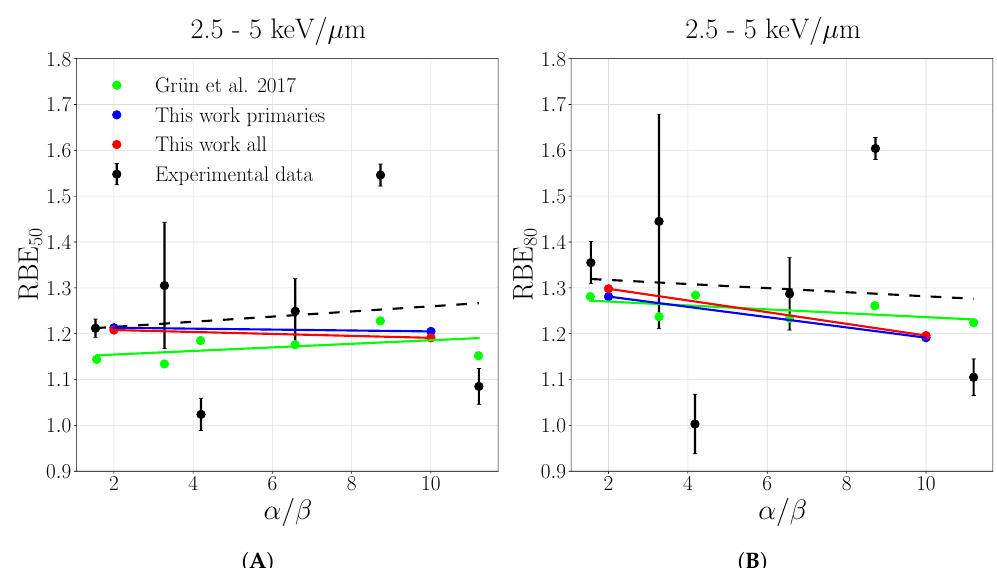
Figure 11. RBE 50 ( A ) and RBE 80 ( B ) as a function of α / β ratio evaluated in LET range of 2.5–5 keV/µm. Solid lines report linear regressions for the purpose to guide the reading. Experimen- tal data from Grün et al. [10], the legend stands for both